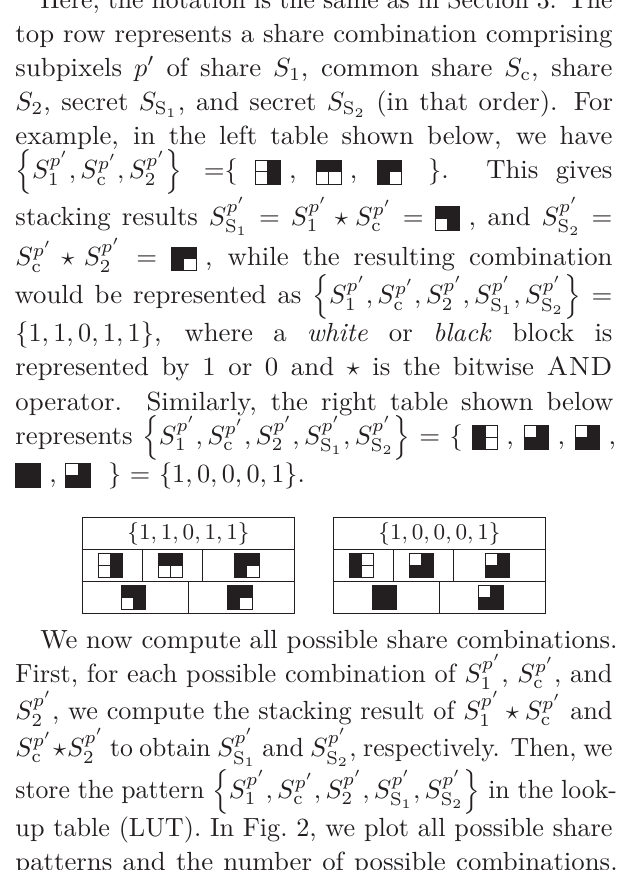
Fig. 2 Number of possible share combinations for each share pattern. A share pattern is represented by five 0 or 1 digits (0 and 1 indicating black and white pixels, respectively). In order, the five digits represent the block color of share S p (cid:2) 1 , common share S p (cid:2) c , share S p (cid:2) 2 , the stacking result of S p (cid:2) 1 (cid:2) S p (cid:2) c = S p (cid:2) S , and S p (cid:2) c (cid:2) S p (cid:2) 2 = S p (cid:2) S . The results are stored 1 2 in a look-up table